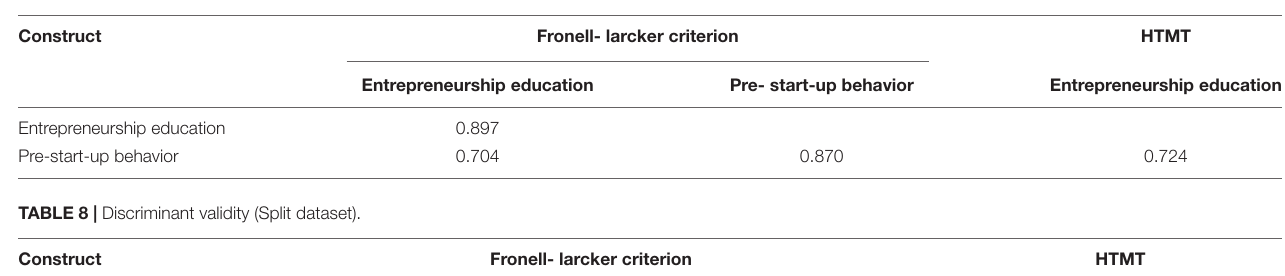
TABLE 7 | Discriminant validity (Full Dataset).